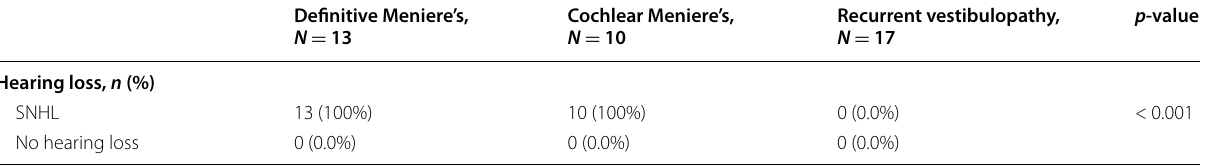
Table 4 Pure tone audiogram abnormality in the three study groups Definitive Meniere’s,